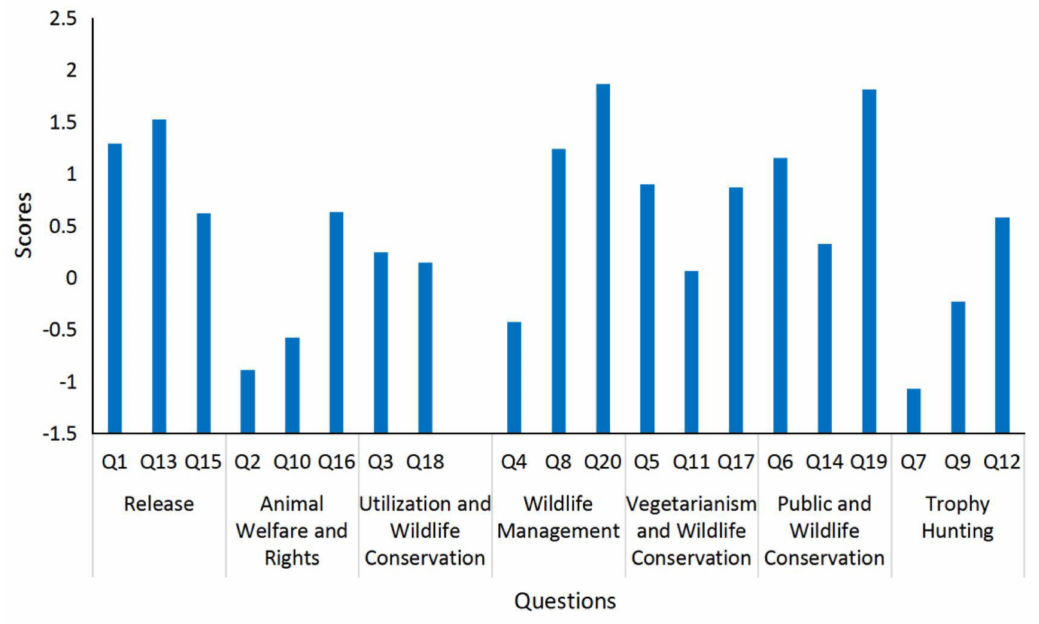
Figure 2. The mean scores of twenty questions on attitude questionnaires based on a Likert